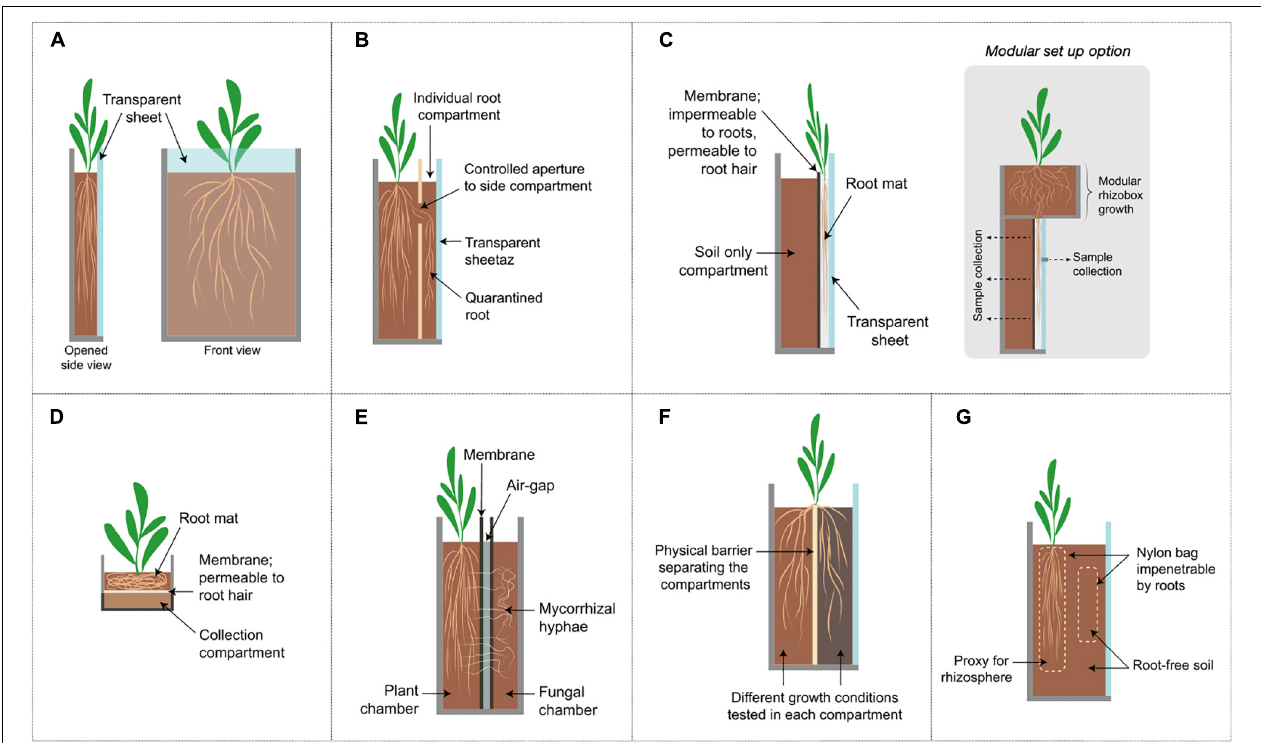
FIGURE 2 | Schematic diagrams of representative growth chamber designs. Further description and characteristics are listed in Table 1 . (A) Rhizotron/Rhizobox set up, (B) Rhizobox with side-compartment, (C) vertical root mat chambers; a modular option is show where the plant can be pre-grown in a separate compartment and transplanted afterward onto the main examination chamber, inset shows a modular set up option, (D) horizontal root mat in rhizobox, (E) Mycorrhizal compartments, (F) split-root systems shown here in a rhizobox set up; (G) Nylon bag to separate root and root-free soil; roots may be restricted in the bag or the soil may be protected from root penetration by the